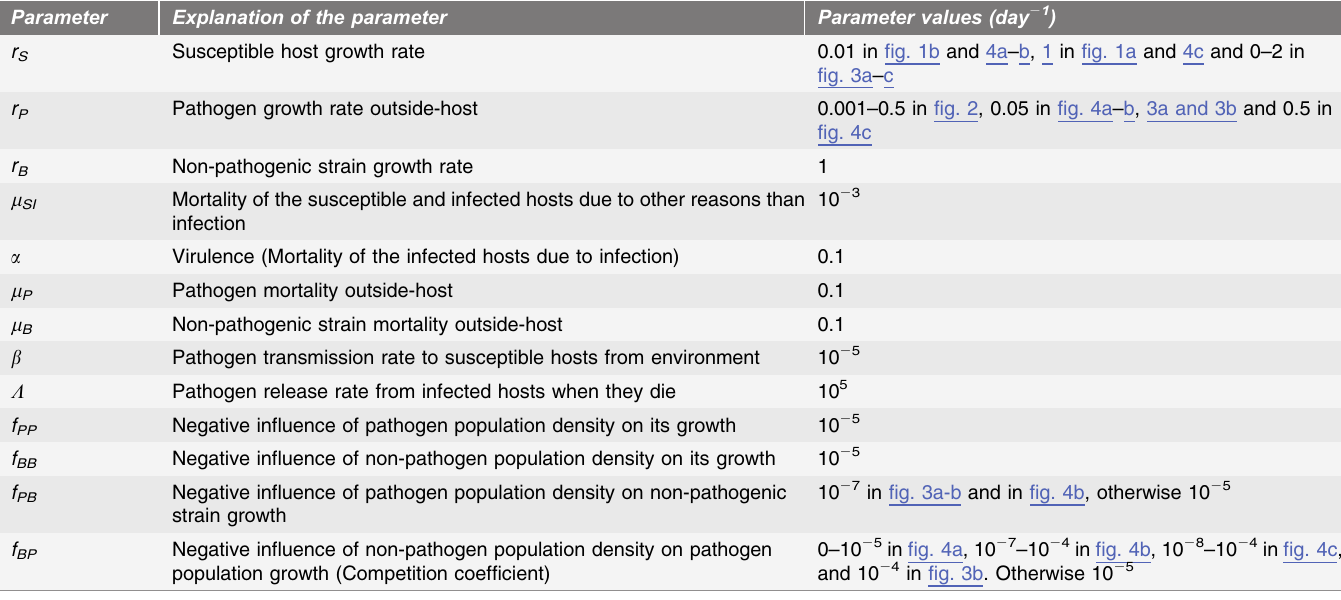
Table 2. Parameter values per time unit (one day) used in the stability